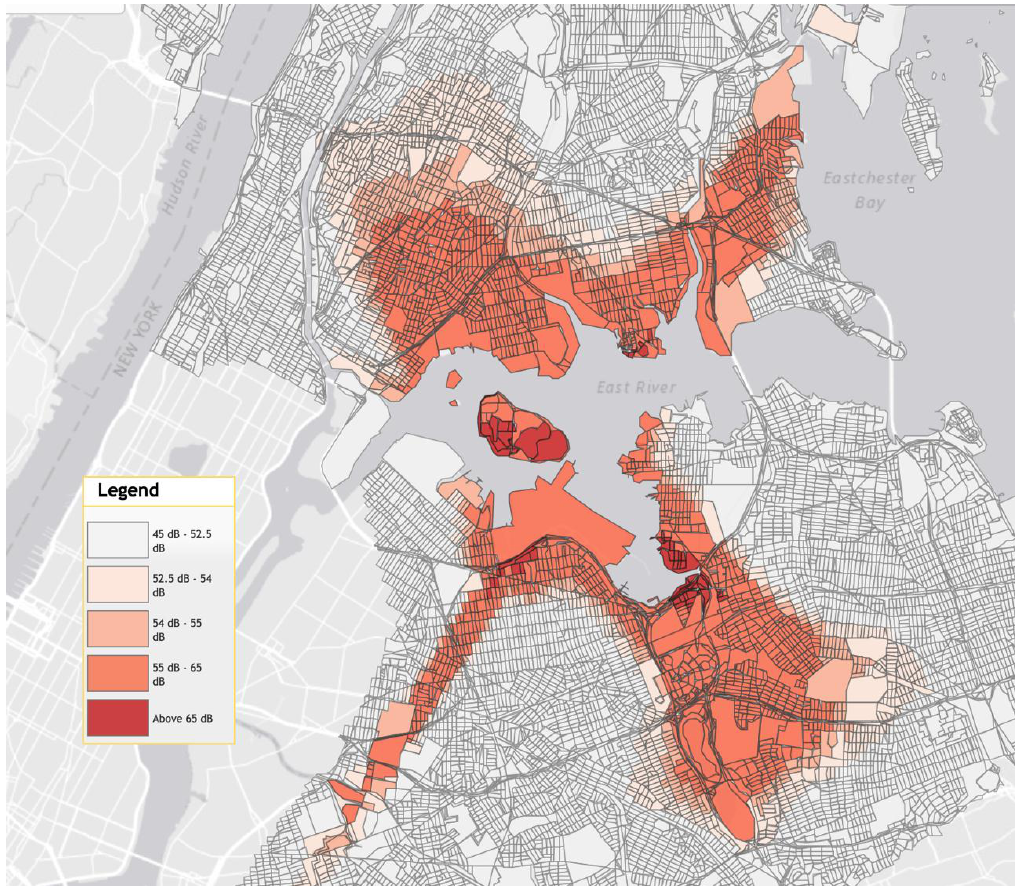
Figure 1. Noise levels around La Guardia Airport. Source: MSP FairSkies Coalition and University of Minnesota Center for Urban and Regional Affairs , 2010 [23].